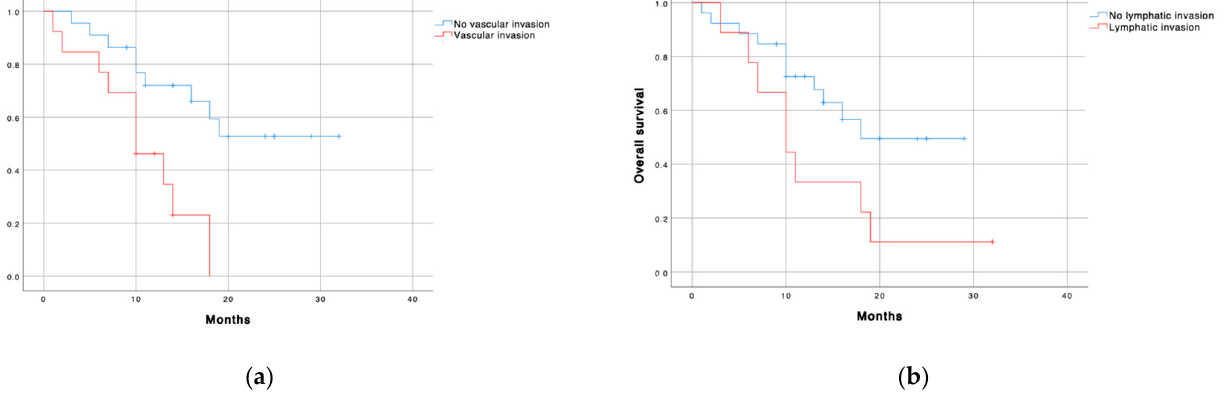
Figure 2. Overall survival according to left) PV-CTC’s cut-off; and right) PV-cluster number´s cut-off. Blue line: low cellular expression; Red line: high cellular expression. ≥ 185 CTC HR = 3.263 (1.135–5.221); p = 0.028. ≥ 15 clusters HR = 2.486 (0.989–6.247); p = 0.053.